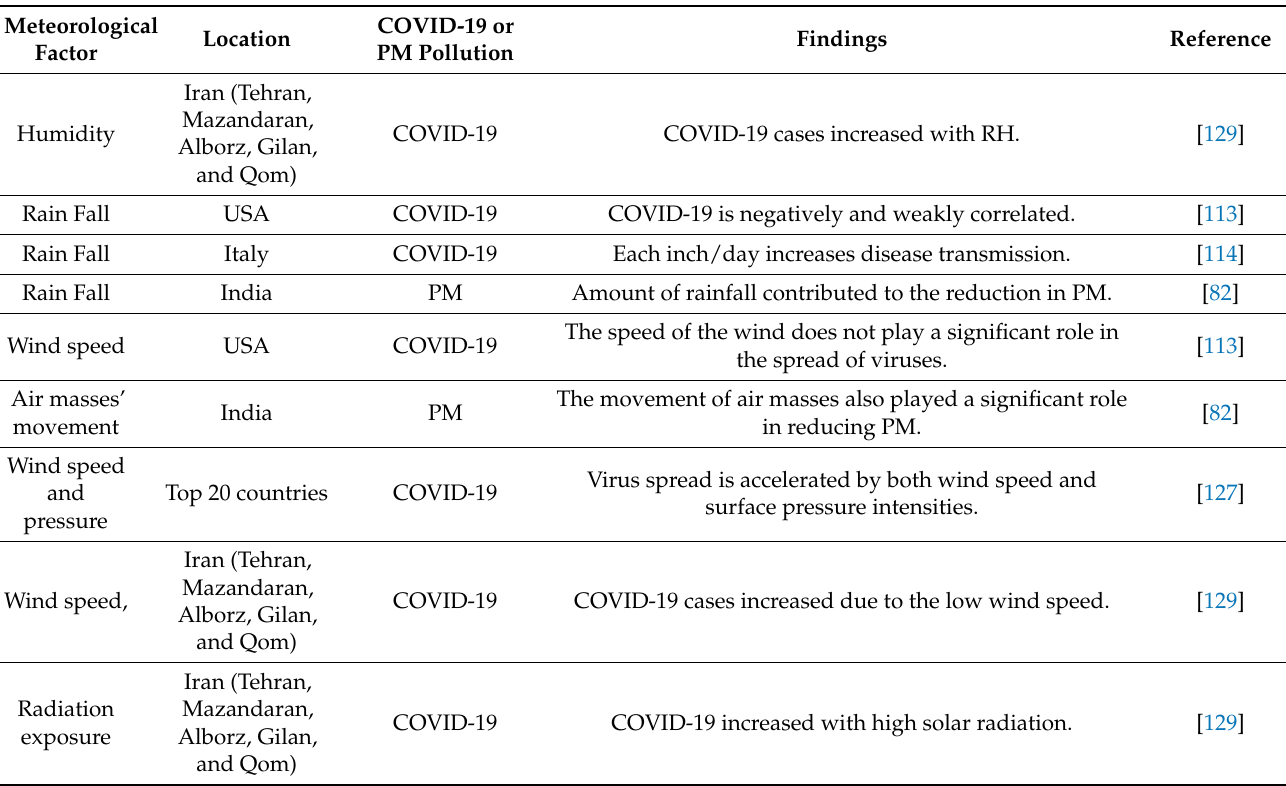
Prior epidemiological research has shown an important relationship between exposure to outdoor pollutants and lung disease and heart disorders [130,131]. Moreover, the toxicity of PM is directly related to its size [132]. Fine-fraction PM 2.5 is relatively more persistent in the atmosphere and can easily be moved into the human body by air (Figure 5). Exposure to PM 2.5 can reduce life expectancy by 5.5 years [133].